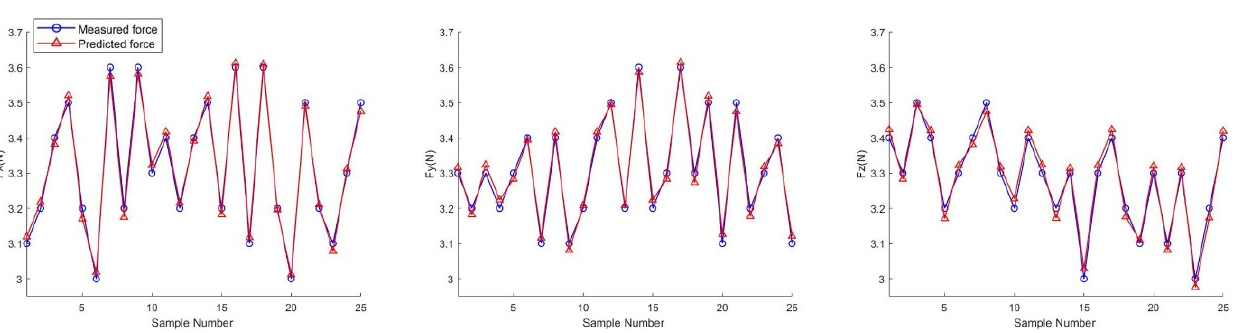
Figure 12. The measured and predicted values of the sensor when different forces are applied to the sensor in X, Y and Z directions, respectively.